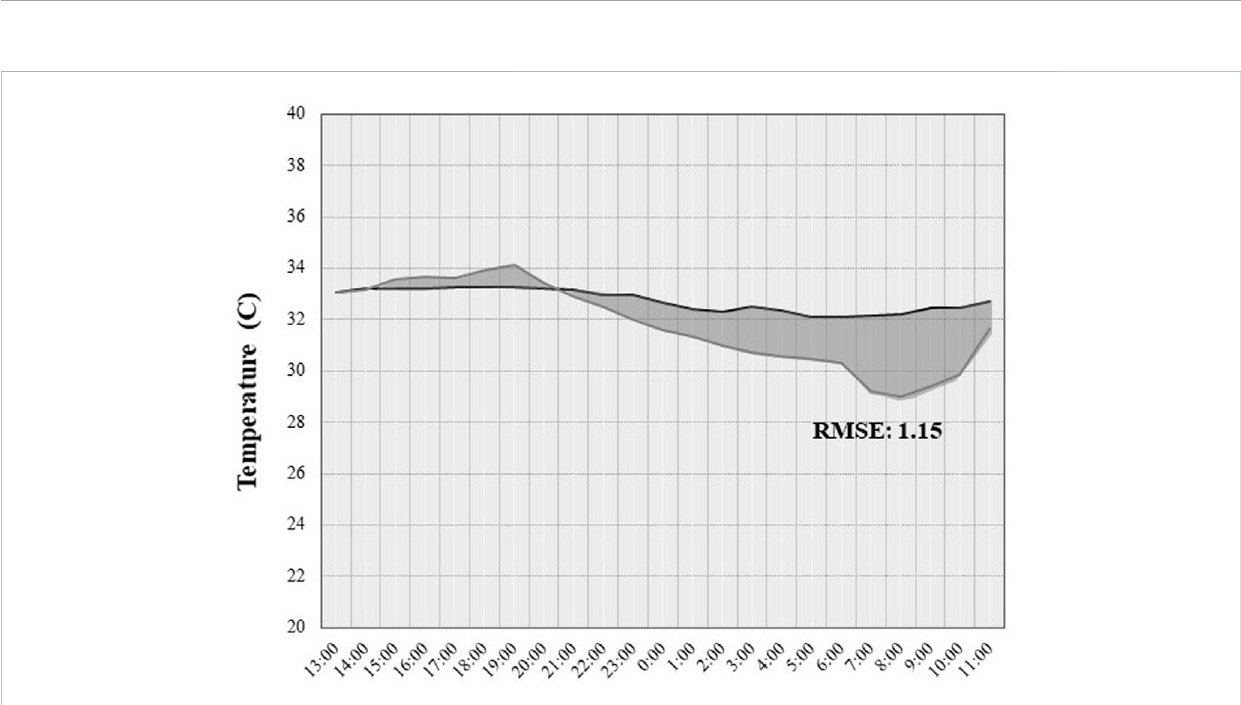
FIGURE 7 Top, coping capacity, adaptive capacity, and related vulnerability under the extreme scenario. Bottom, results of adaptation